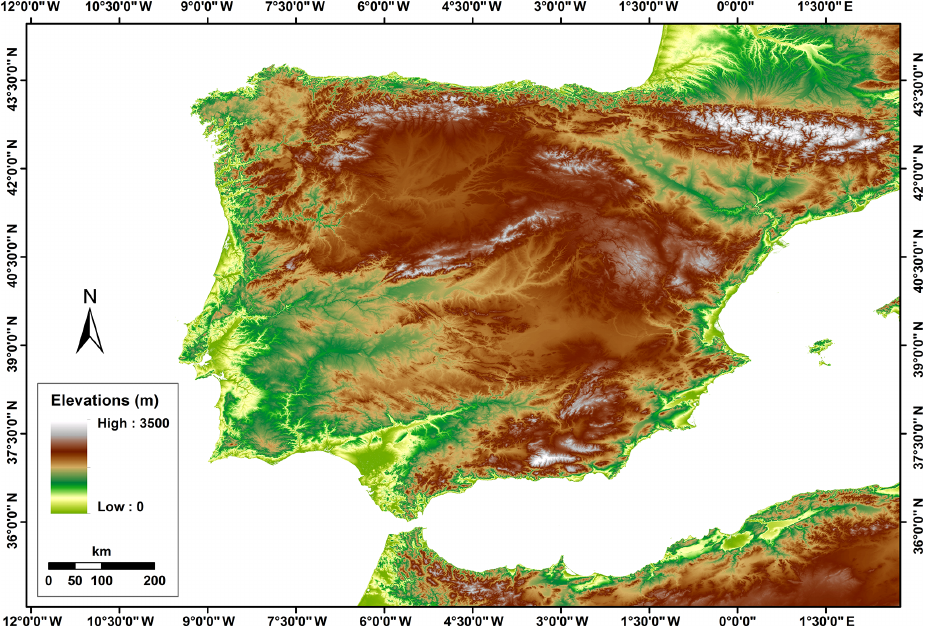
Figure 1. Map of Iberian Peninsula case study